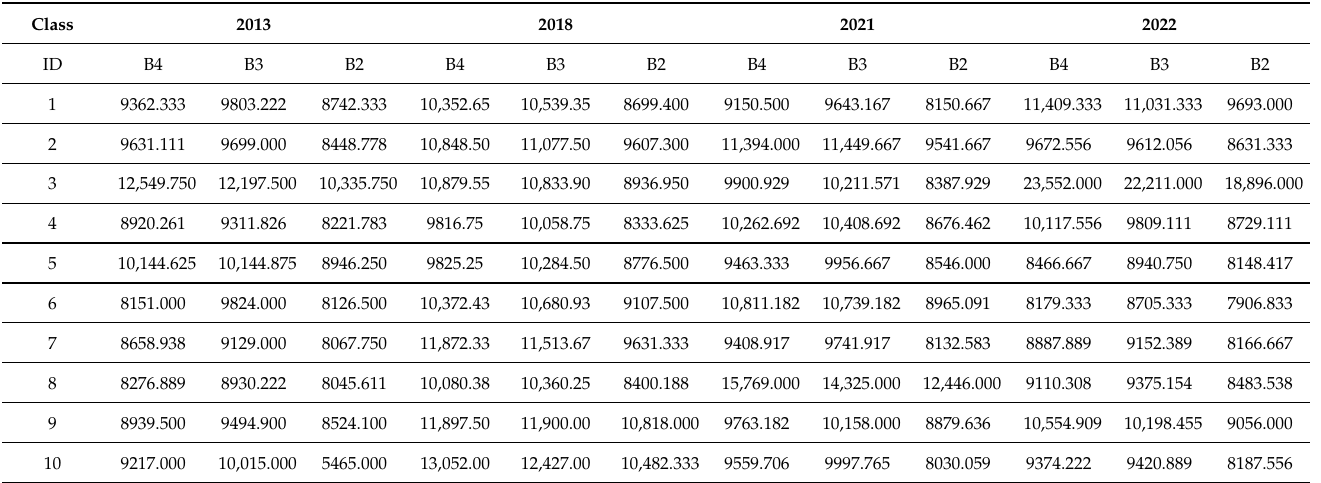
Table 3. Results of the land cover class classification by pixel content in Band 4 (Red), Band 3 (Green) and Band 2 (Blue) of the Landsat-8 OLI/TIRS satellite